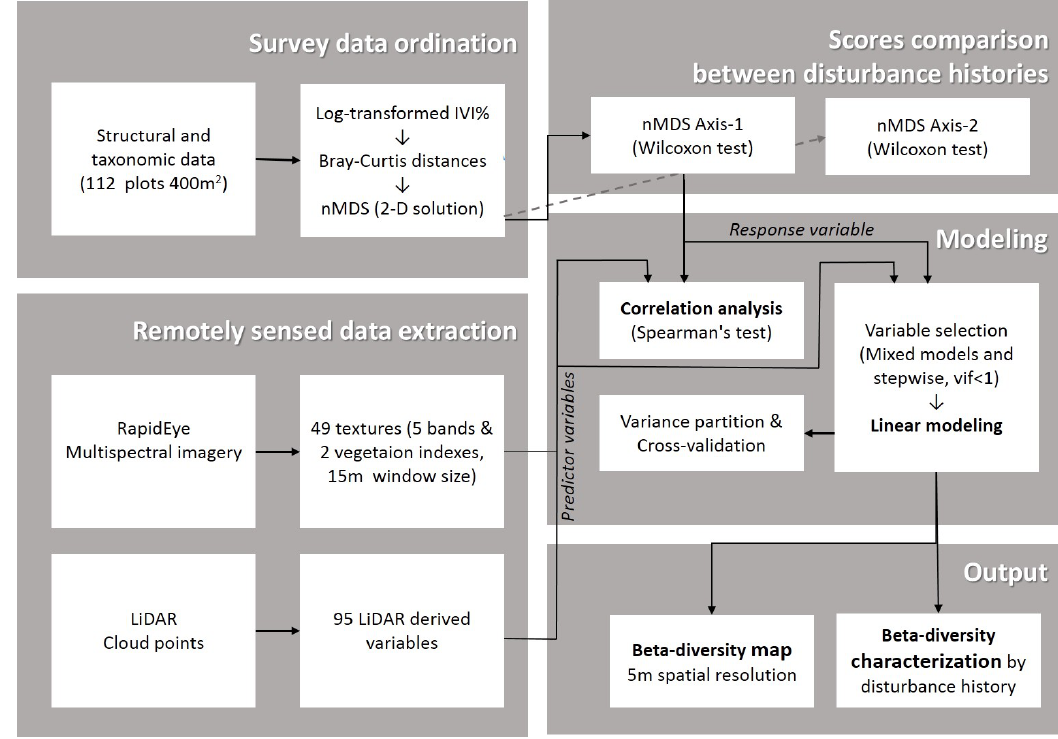
Figure 1. Flowchart representing the whole procedure. Log-transformed percentage Importance Value Indexes (IVI%) of the species at plot level were ordinated onto a 2-D non-metric multidimensional scaling ordination (nMDS). Differences between disturbance histories were tested for each